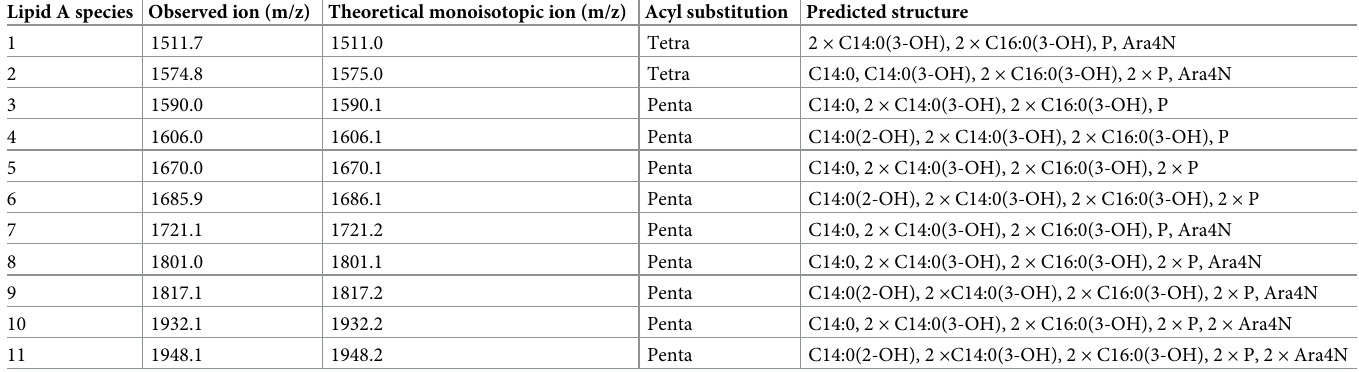
Table 1. Negative ion MALDI-TOF and ESI-QqTOF MS lipid A species and predicted structures of the fatty acid, phosphate and carbohydrate substituents on the B . pseudomallei K96243 lipid A backbone.